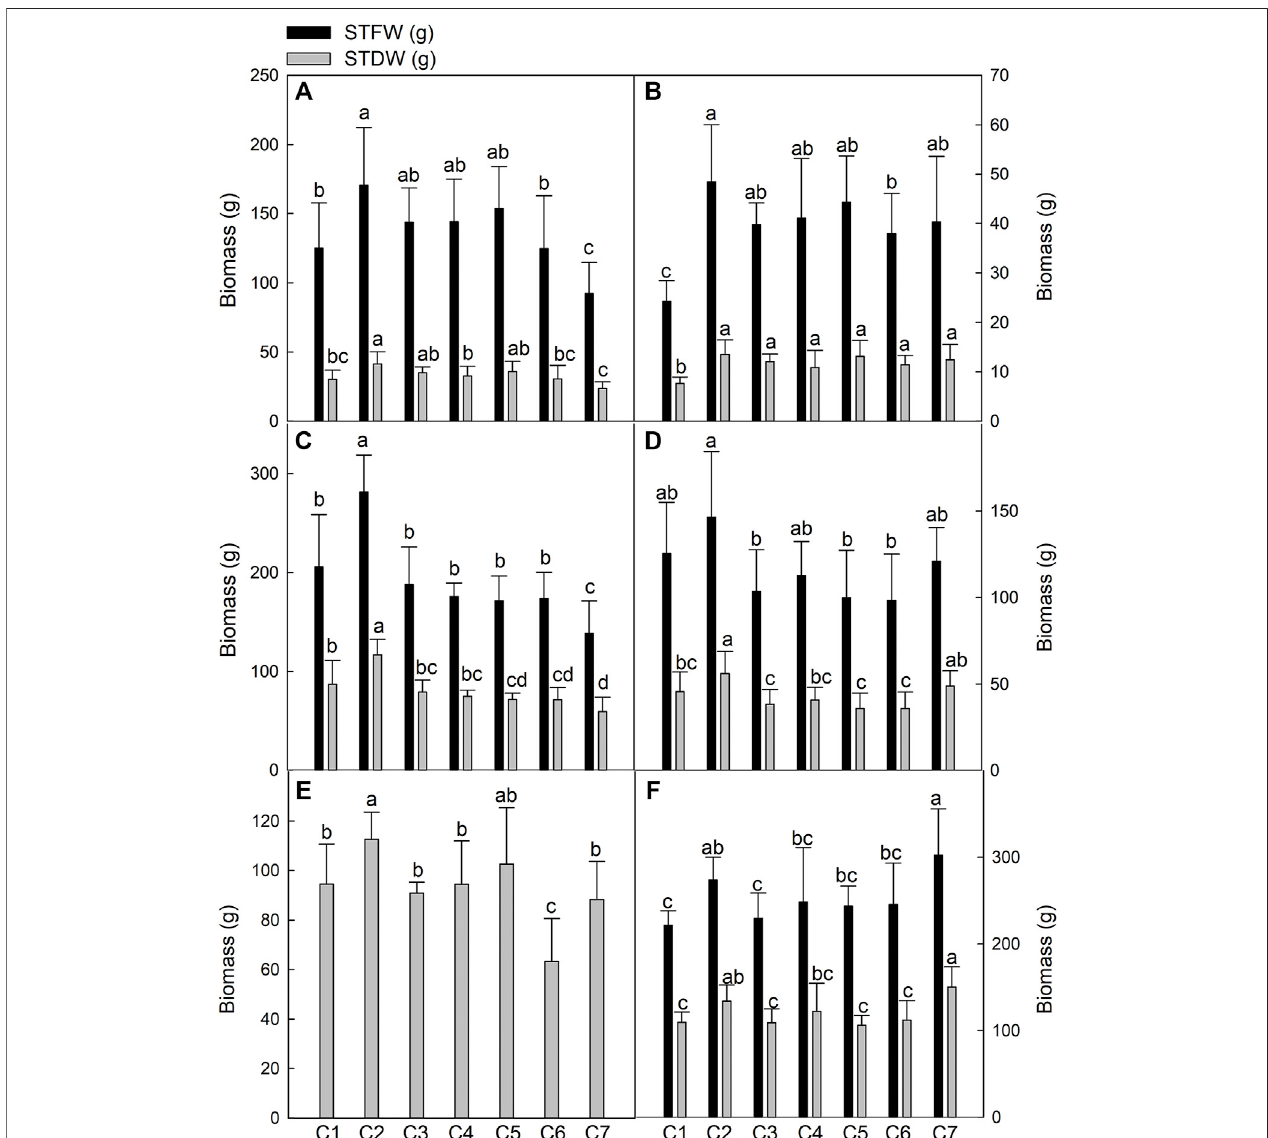
FIGURE 1 | Comparison of biomass of seven Th. ponticum lines at the fl owering stage at Haixing station in 2018 (A) , at the fl owering stage at Dongying station in 2018 (B) ,atthemilk-ripestageatHaixingstationin2018 (C) ,atthemilk-ripestageatDongyingstationin2018 (D) ,atthe fl oweringstageatDongyingstationin2019 (E), and at the milk-ripe stage at Dongying station in 2019 (F) . STFW, shoot total fresh weight; STDW, shoot total dry weight. Different letters indicate a signi fi cant difference between seven Th. ponticum lines at p < .05 level.